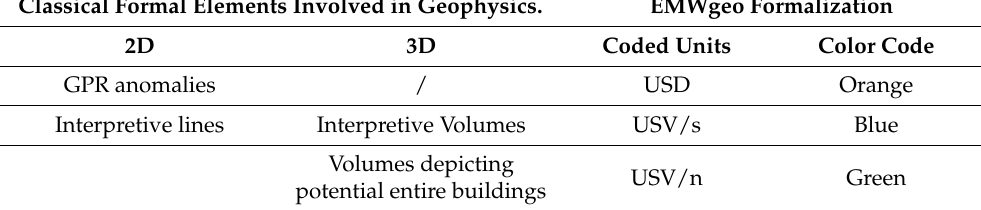
Table 1. Mapping between geophysical anomalies and interpretative lines (direction of the buried walls) and hypotheses by means of volumes (first two columns on the left) with the EM coded formalization by means of colored 3D proxies. Classical Formal Elements Involved in